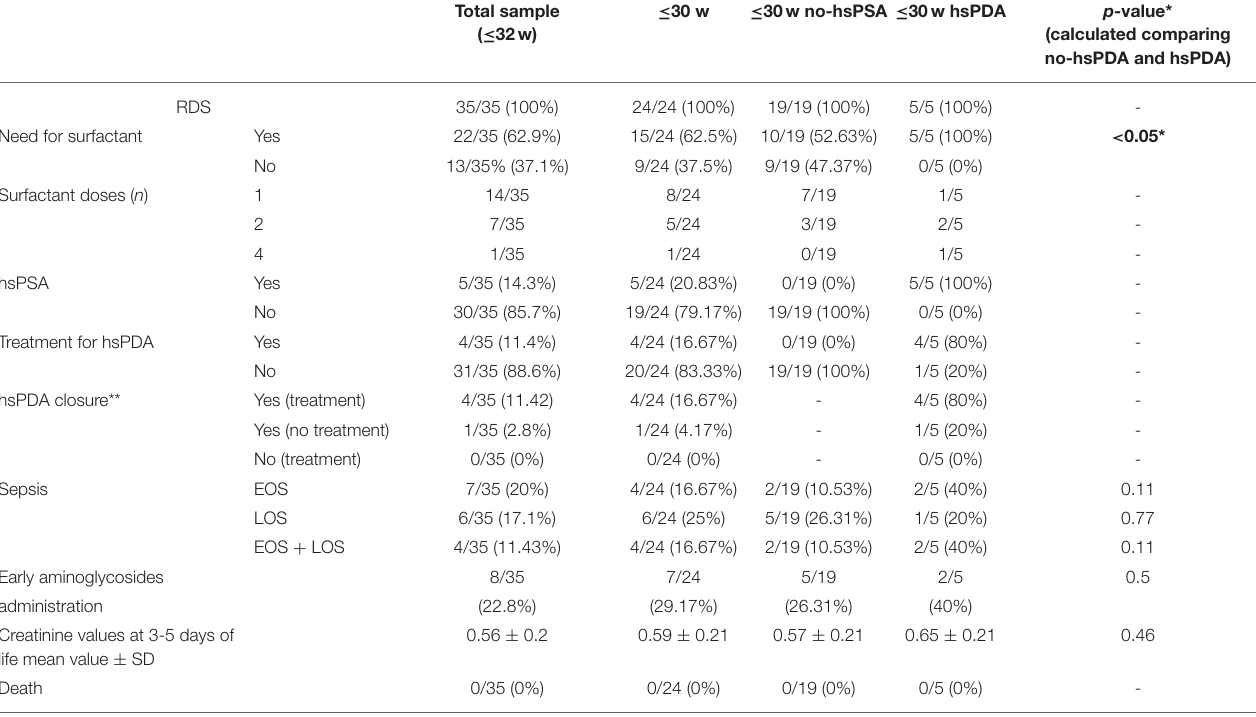
TABLE 3 | Neonatal early outcome.